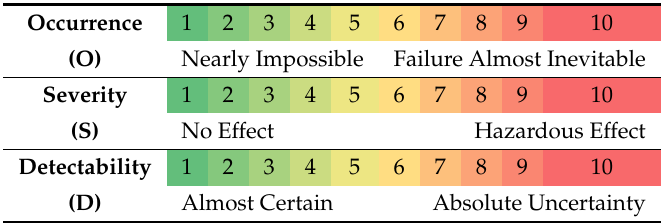
Table 1. Failure Mode and Effect Analysis (FMEA) parameters for the Risk Priority Number (RPN) calculation Variables.